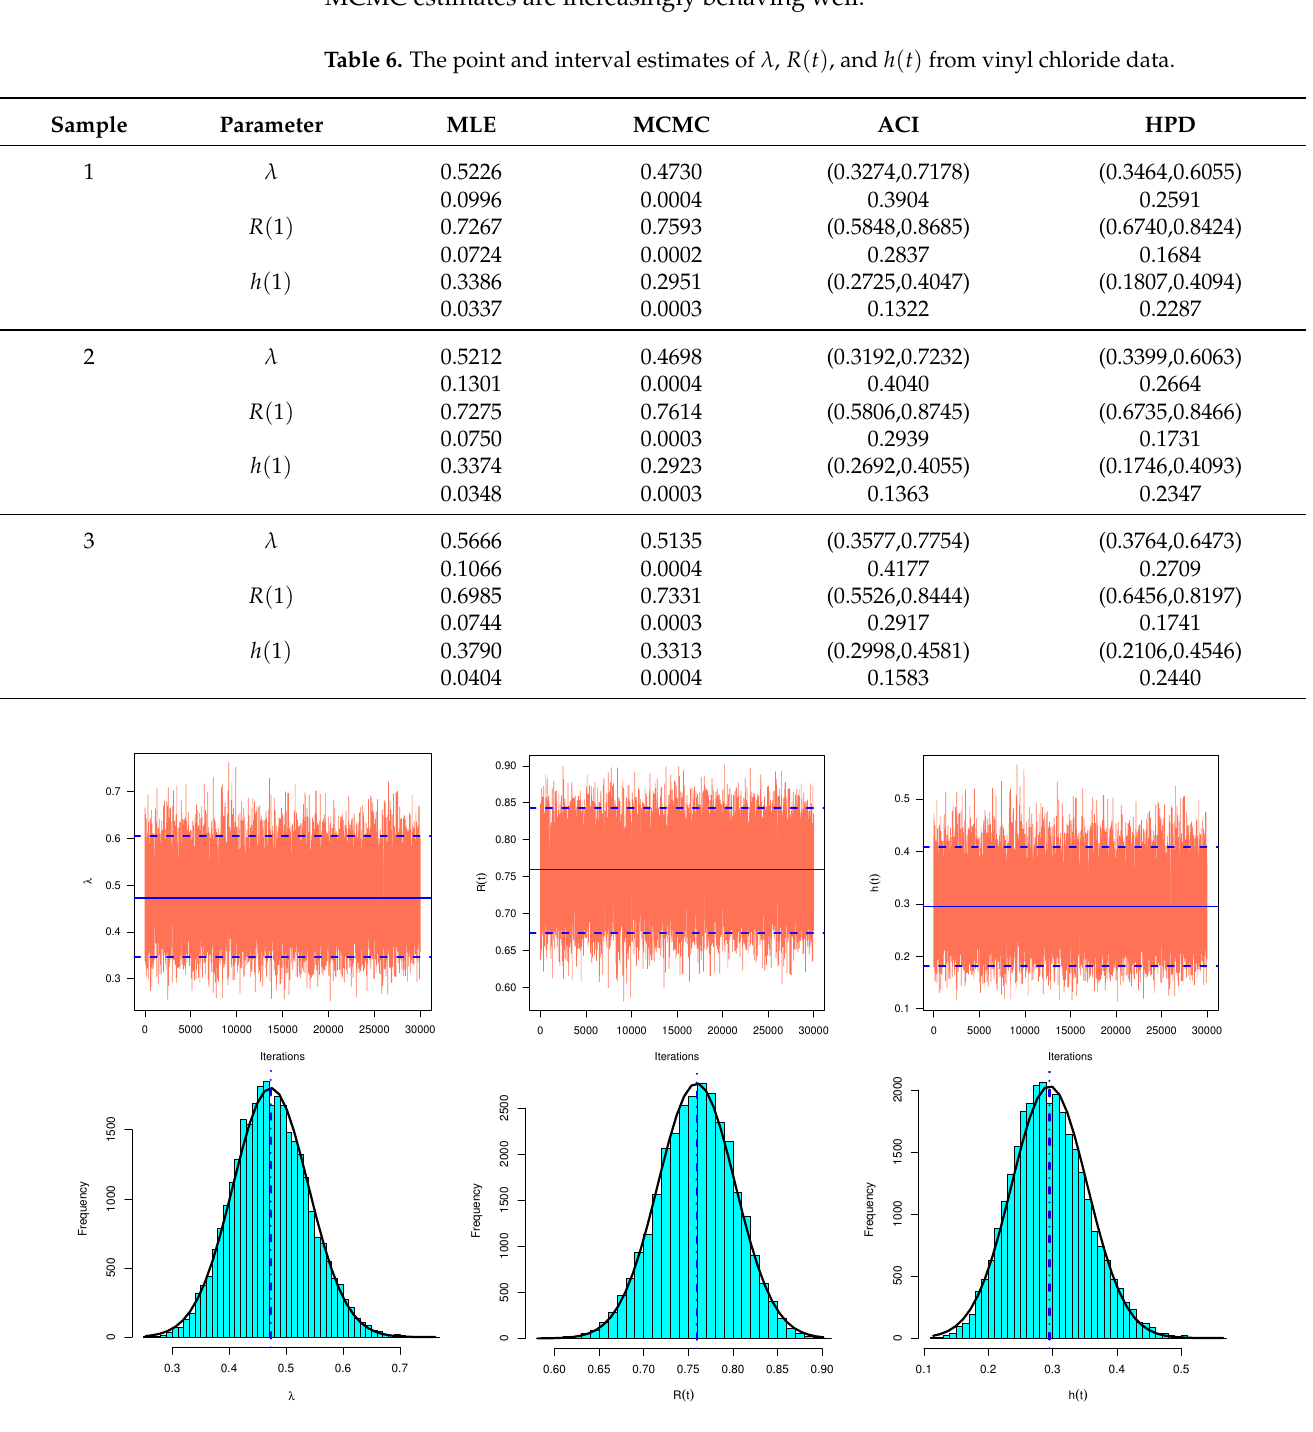
Figure 14. Trace plots ( top panel ) and histograms ( bottom panel ) of λ , R ( t ) , and h ( t ) from vinyl chloride